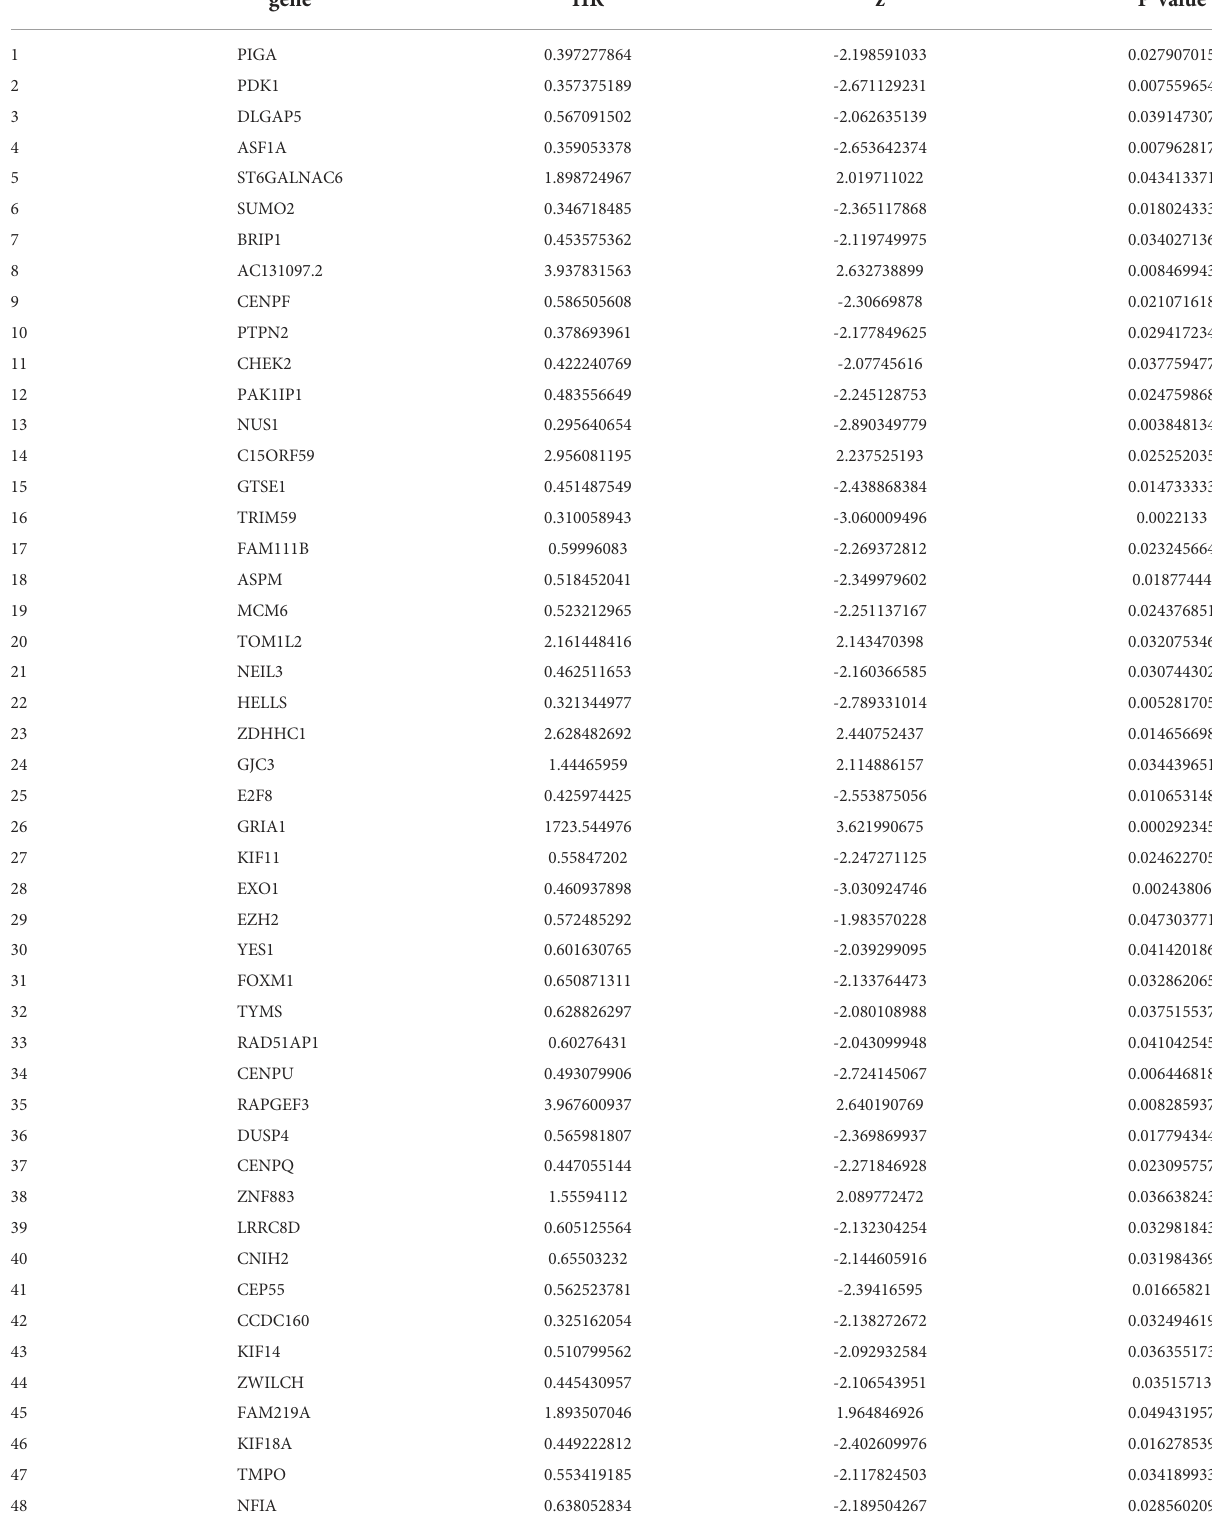
TABLE 2 The 106 prognostic genes obtained by the univariate Cox regression analysis.